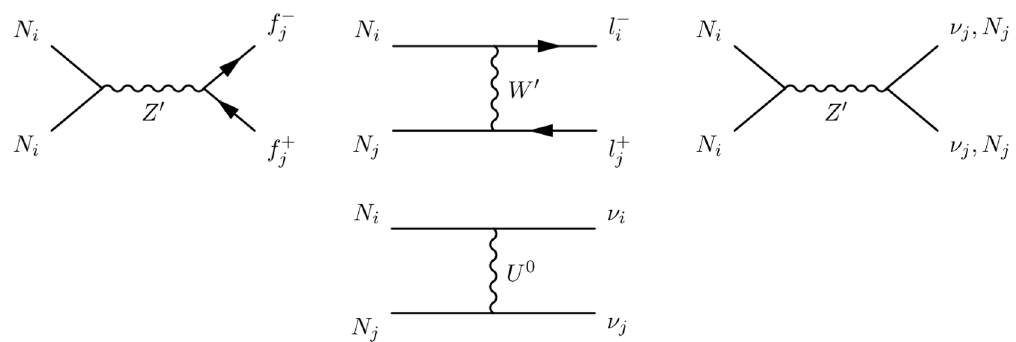
Figure 1 . Processes that contribute to N i freeze-out where f represents the charged fermions of standard models and l represents the charged leptons with i, j = 1 , 2 , 3